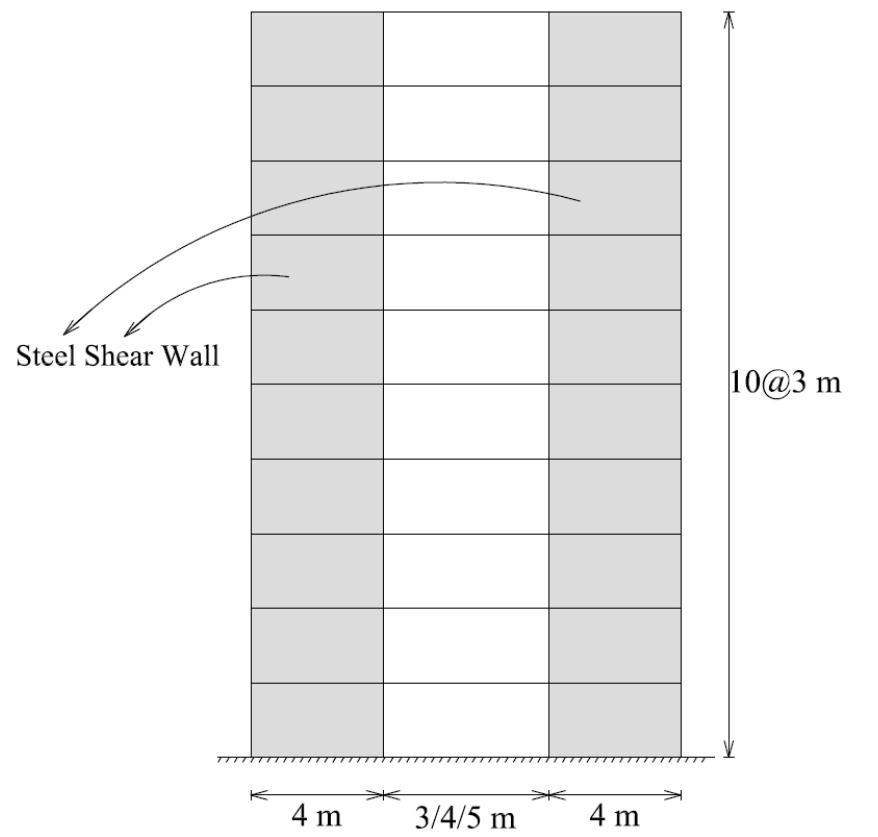
Fig. 4. Layout of the 10- story